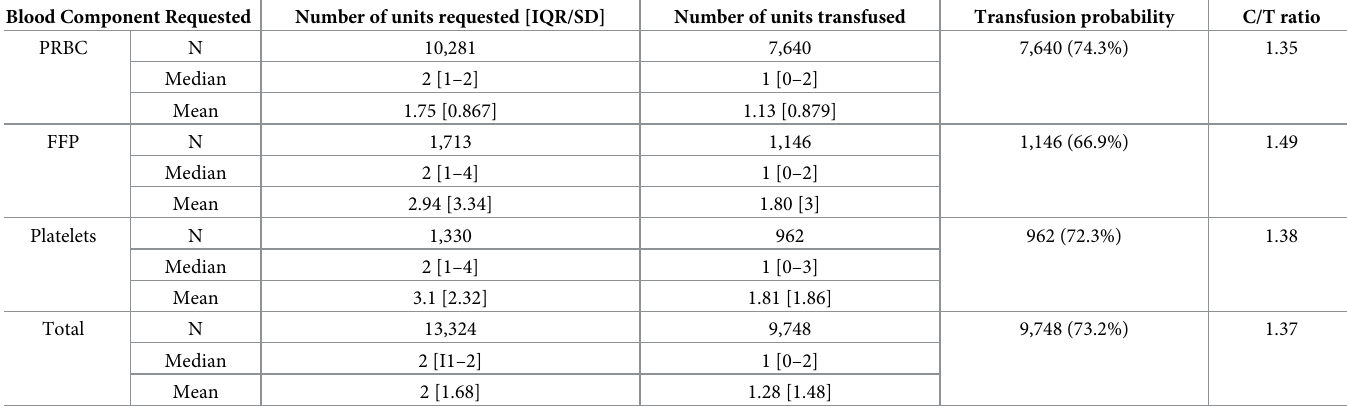
Table 3. Crossmatch transfusion ratio according to blood product.